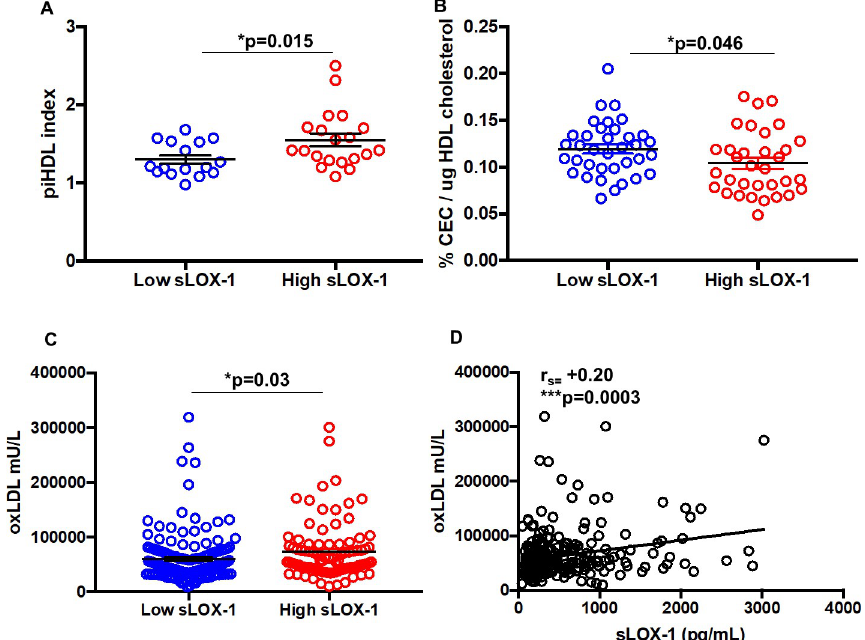
Fig 3. Assessment of lipid function in low and high sLOX-1 SLE patients. (A) Increased proinflammatory HDL (piHDL) in high sLOX-1 (n = 20) SLE patients versus low sLOX-1 (n = 16) SLE patients using DCFDA as a substrate to measure LDL oxidation; (B) Cholesterol efflux capacity of SLE HDL from donors with low sLOX-1 (n = 36) and high sLOX-1 (n = 33). Global cholesterol efflux capacity (CEC) was normalized to total HDL cholesterol